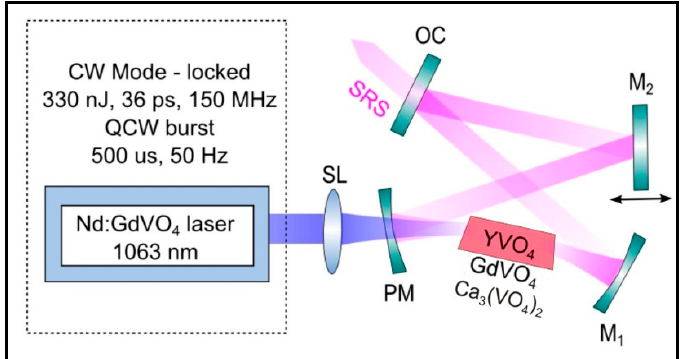
Figure 3. The experimental setup of the synchronously pumped extracavity crystalline Raman laser.